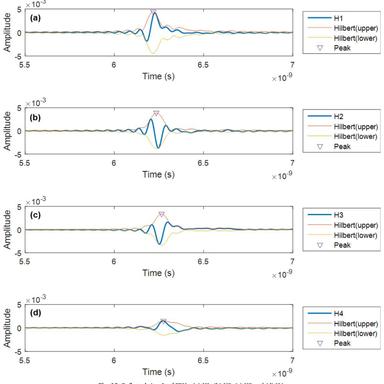
Reflected signals of FBHs: (a) H1, (b) H2, (c) H3 and (d) H4.